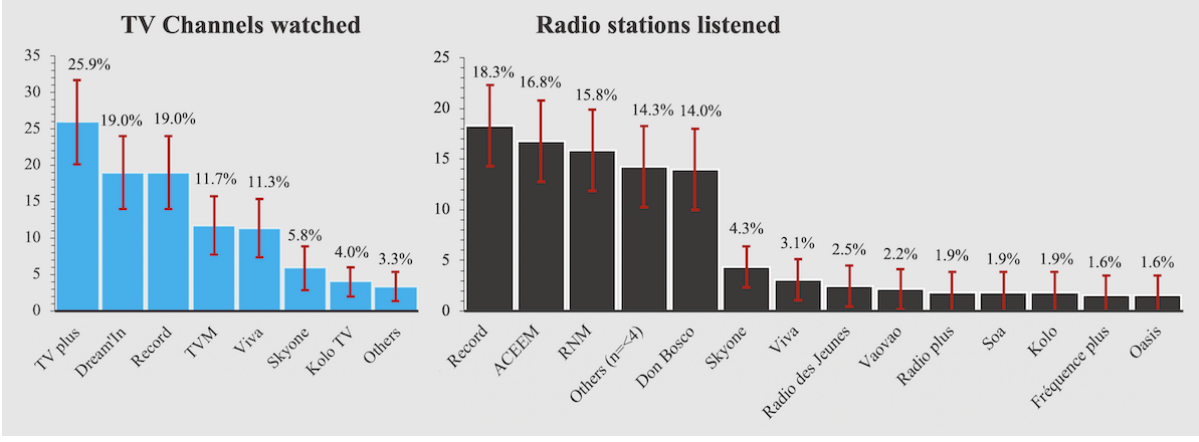
Figure 2. Media consumption among pregnant women and new mothers in Antananarivo (Atsimondrano and Renivohitra districts), Madagascar. TV: N=228. Radio: N=277. Error bars represent 95%